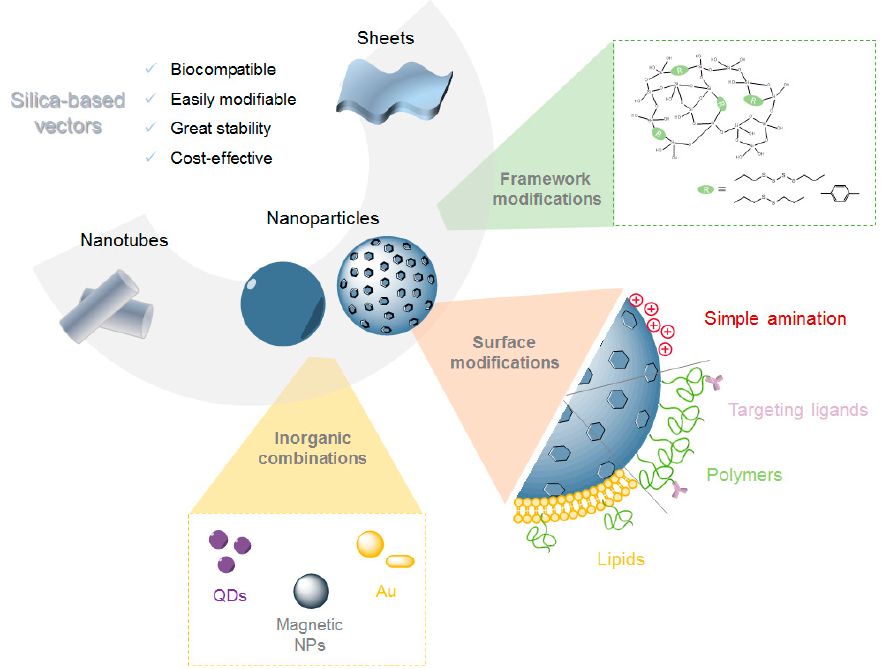
Figure 2. Different types of silica-based vectors reported for gene therapy and discussed in the present review.